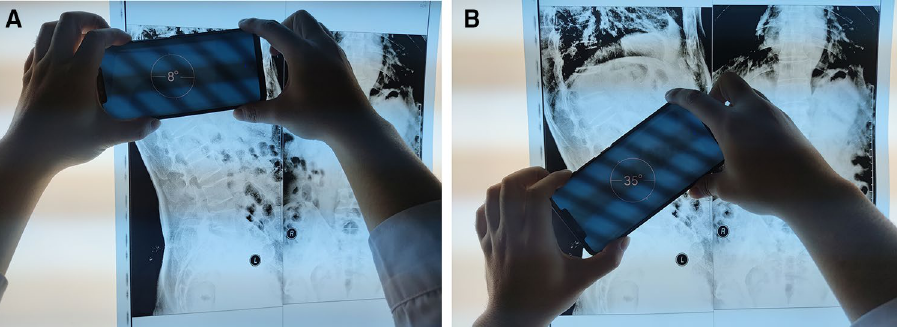
Figure 2. The integrated inclinometer in a smartphone was used to measure thoracolumbar kyphosis on lateral plain X-ray films. ( A ) First, the vertebral body of T10 was confirmed, a certain edge of the smartphone was aligned to the upper endplate of T10, and the angle shown on the smartphone screen was recorded. ( B ) Second, the vertebral body of L2 was confirmed, the same edge of the smartphone was aligned to the lower endplate of L2, and the angle shown on the smartphone screen was